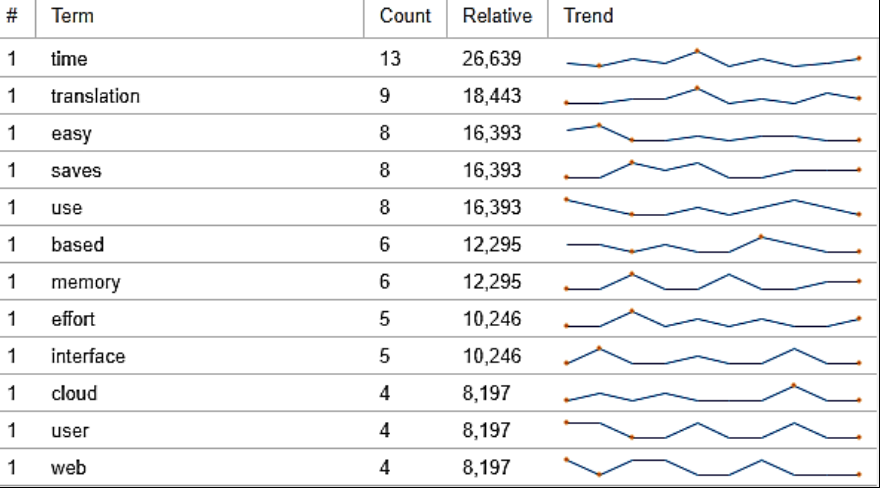
Figure 4. Concordance results for the most frequent word in participants’ responses on the best feature of CAT. 